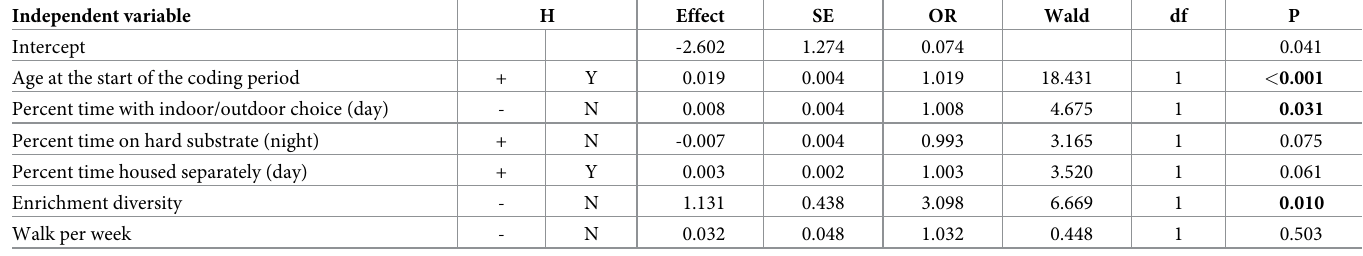
Table 5. Multivariate assessment of the total number of clinical events with housing and management factors by Poisson regression. Hypotheses (H): positive (+) or negative (-) relationship of each variable with the number of clinical events per animal as a measure of elephant welfare, and whether observed relationships were in the predicted direction (Y yes / N